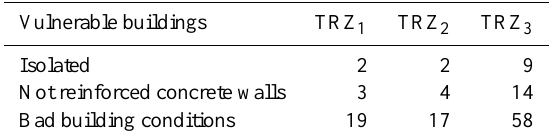
Table 5. Number of persons with vulnerable characteristics in the TRZ i ( i = 1 , 2 , 3).